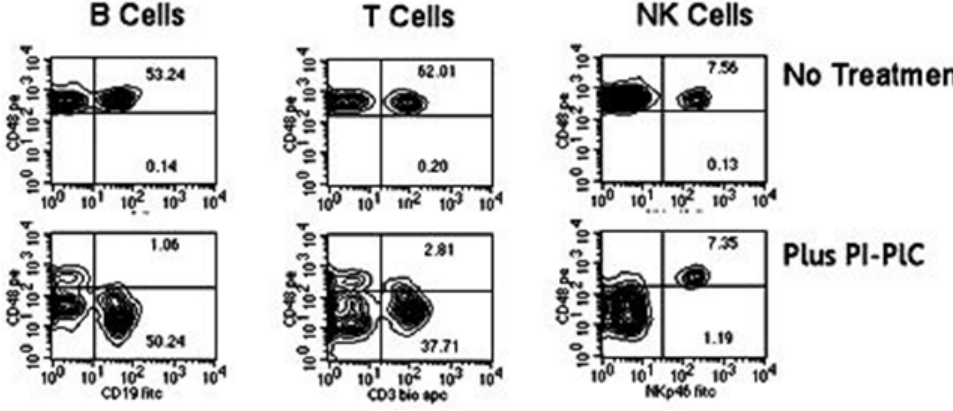
Figure 1. Resistance of NK-CD48 to removal by PI-PLC. Splenocytes isolated from BALB/C mice were incubated with 1.0 units of PI-PLC for 2 h at 37 °C. Subsequently the cells were stained with B- (CD19), T- (CD3), and NK- (NKp46) cell specific reagents together with anti-CD48 antibodies to assess decrease in CD48 levels in comparison to non-treated control